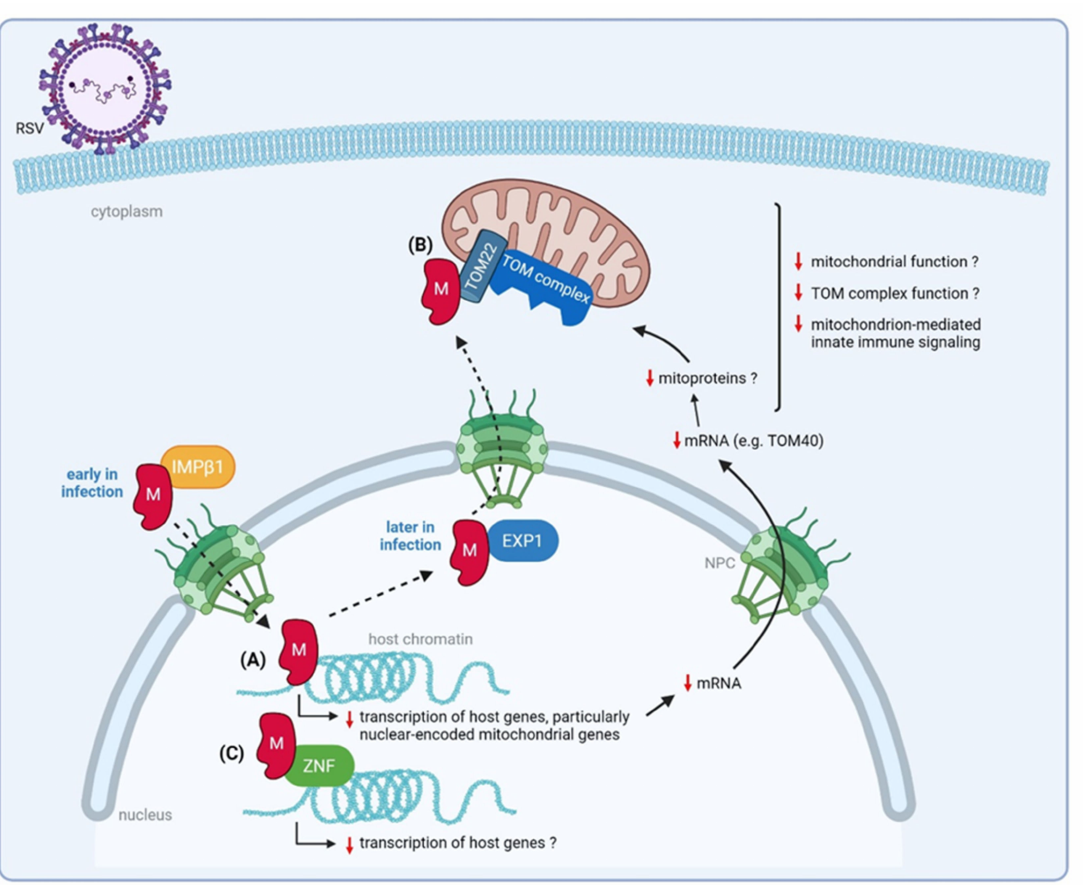
Figure 6. Proposed roles of RSV M in suppression of host innate immune responses. Early in infection, M translocates to the host nucleus. ( A ) Nuclear RSV M associates with host chromatin, resulting in inhibition of host gene transcription, in particular nuclear-encoded mitochondrial